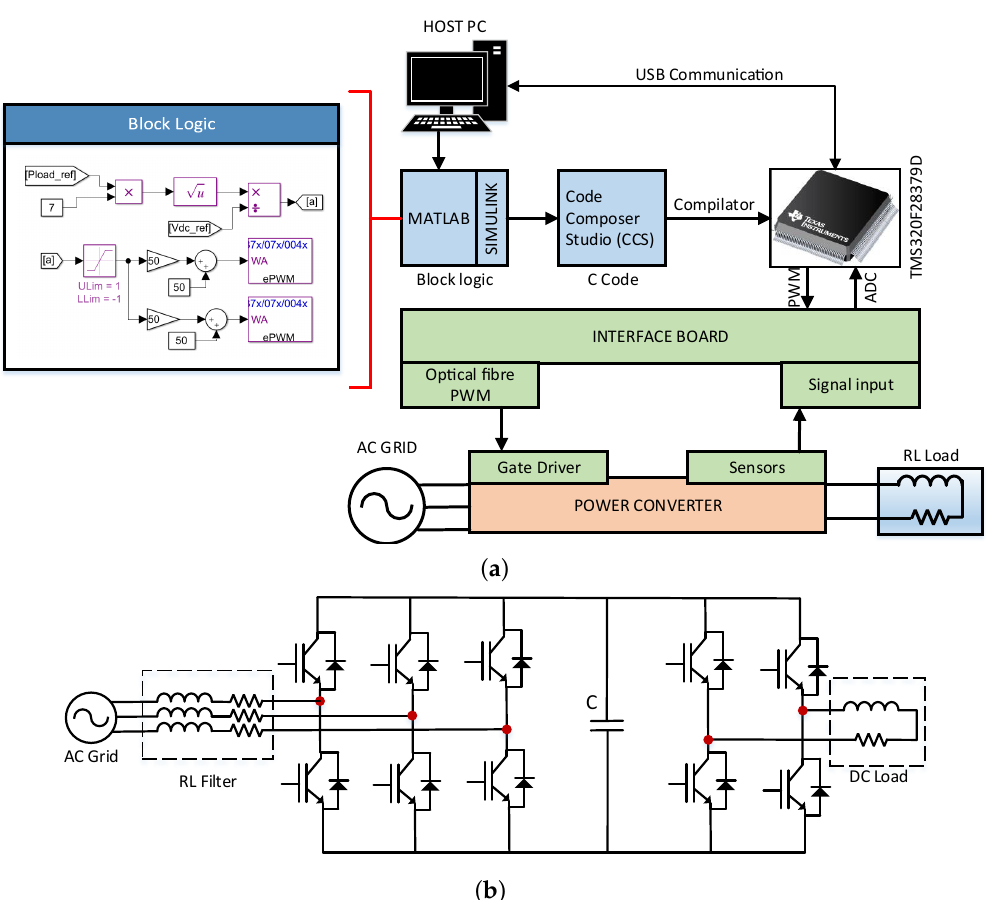
Figure 7. ( a ) Overview of the experimental setup. ( b ) AC-DC back-to-back converter topology.